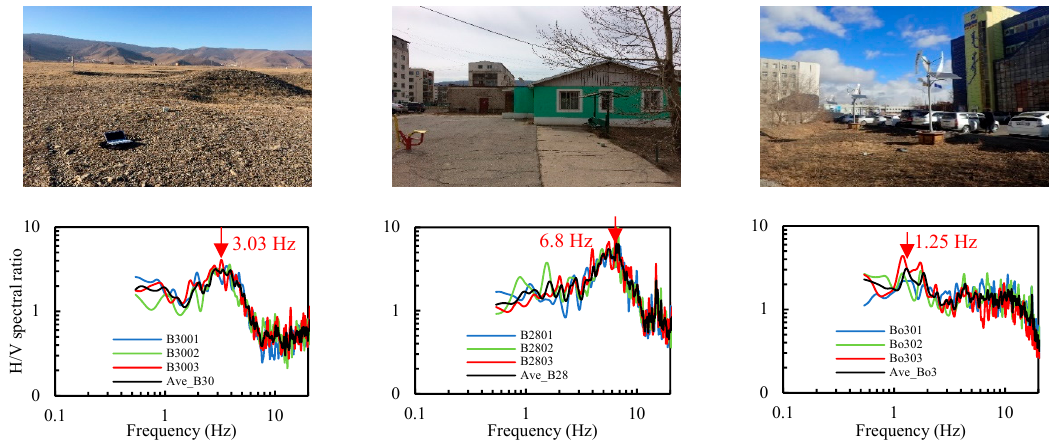
Figure 3. Typical site observation photos and observed H/V spectral ratios at B30, B28, and BO3.